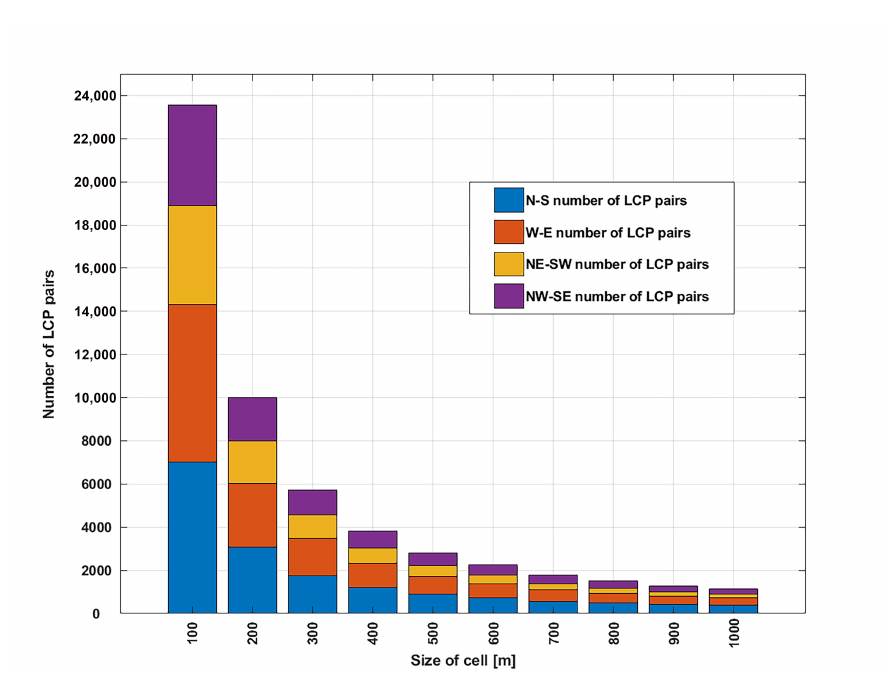
Figure 8. Number of LCP pairs at four different spatial directions as a function of cell size, ∆ x , ∆ y .